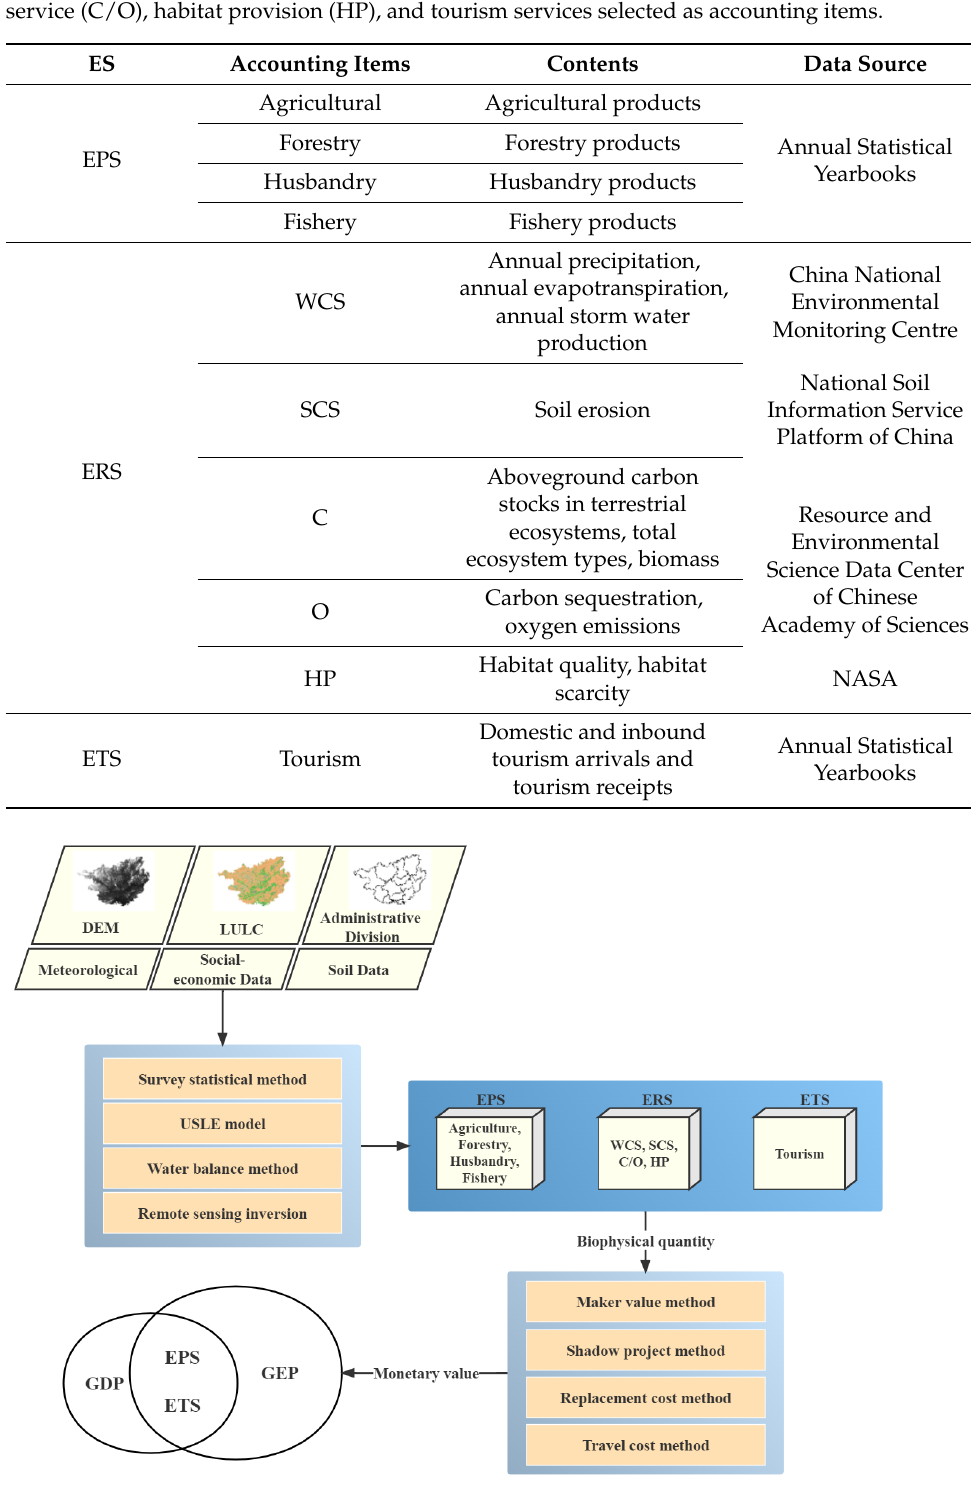
Figure 2 . GEP accounting technical route. Figure 2. GEP accounting technical